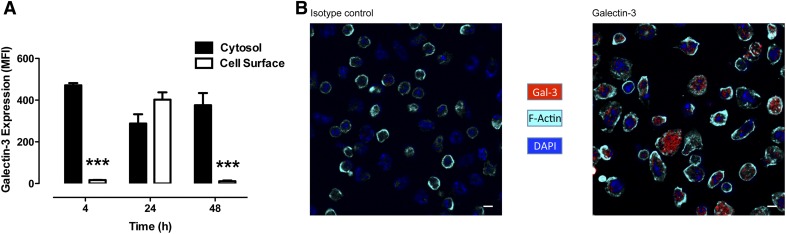
Cytosolic and cell surface expression of Gal-3 in murine neutrophils taken from the peritoneal exudate at 4, 24, and 48 h after zymosan ip.Surface Gal-3 expression was measured by flow cytometry on Ly6G+ neutrophils, and total Gal-3 expression was measured after permeabilization. (A) Cytosolic expression was calculated by subtracting the cell surface expression from the total expression. (B) Gal-3 expression in neutrophils taken from the peritoneal exudate at 4 h after zymosan as detected by confocal microscopy. MFI, mean fluorescence intensity. Scale bar = 5 µm. N = 8–12/group. ***P < 0.001 vs. cytosol.